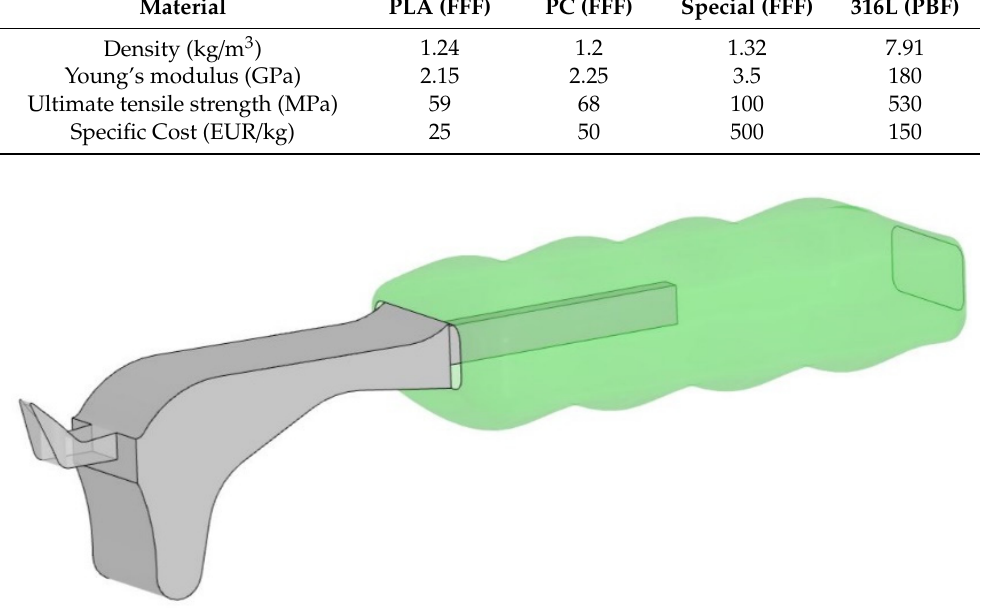
Figure 5. Layout of the product to be optimised.